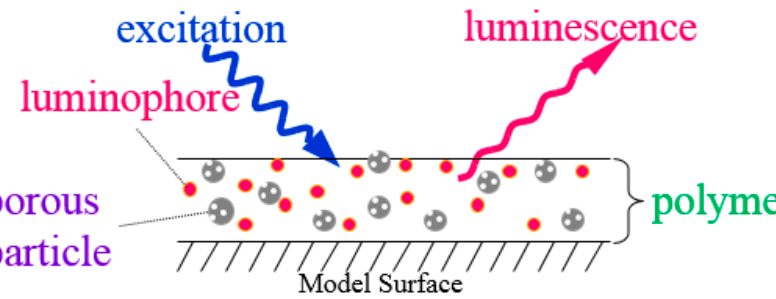
Figure 1. Schematic of polymer-ceramic pressure-sensitive paint (PC-PSP).